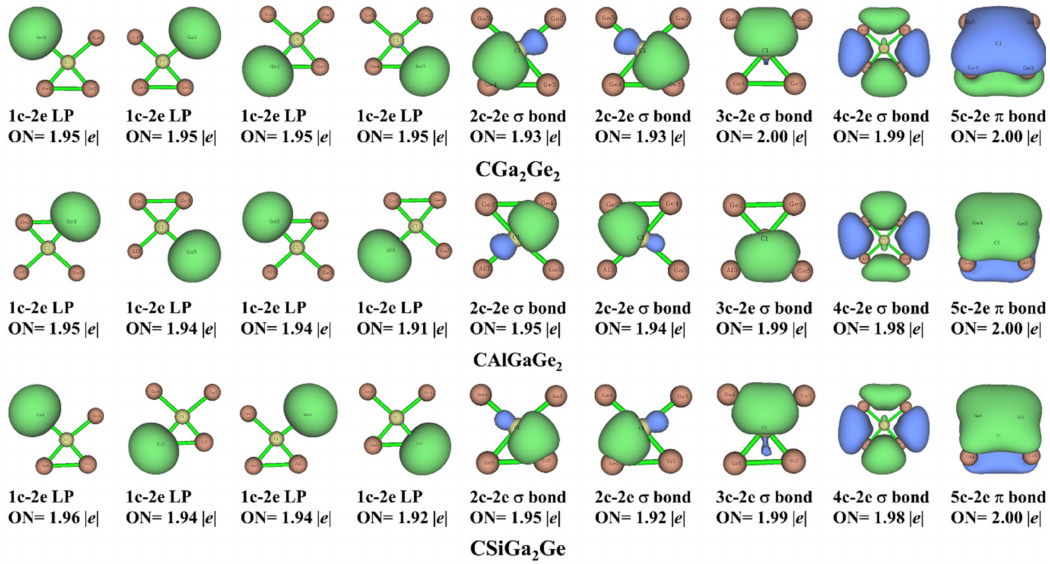
Figure 6. AdNDP bonding patterns of the systems in cis isomer with the occupation numbers